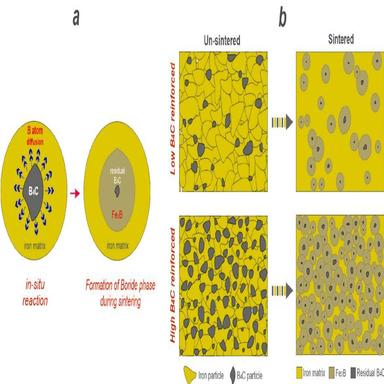
Schematic representation of a) boride phase formation with in-situ reaction, and b) its distribution in Fe matrix depending on the B4C volume fraction.